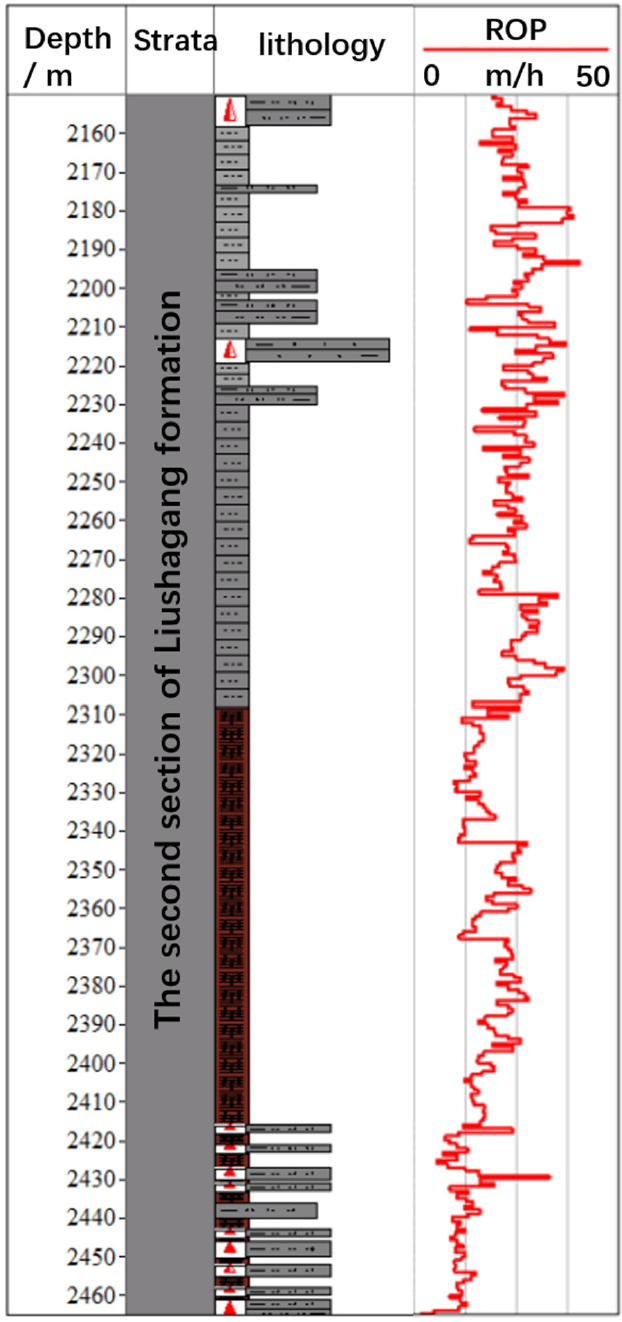
Figure 19. Lithology and ROP profile of Well X-2.